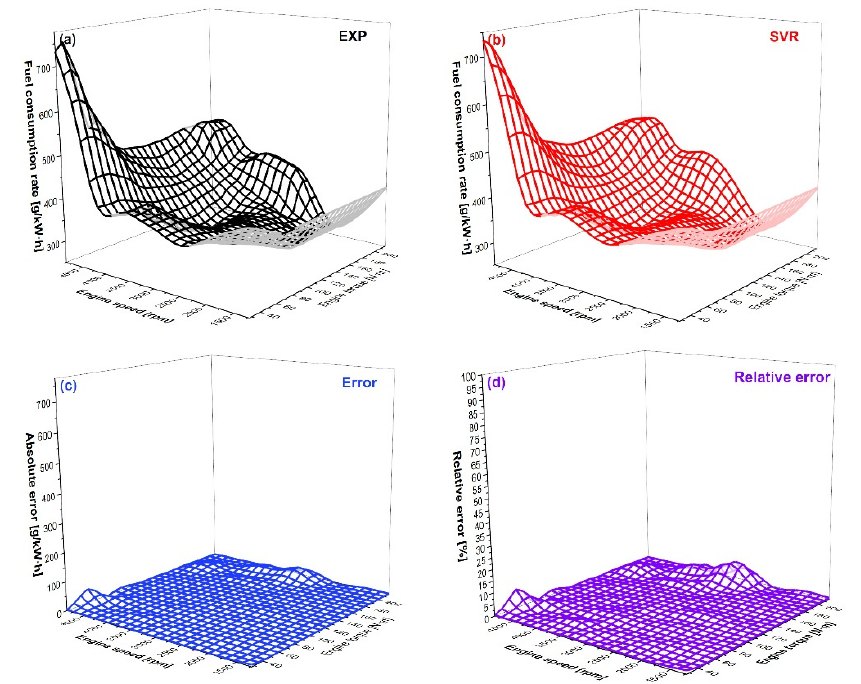
Figure 11. Comparison of SVR-predicted and experimental fuel-consumption-rate-established en- gine map. ( a ) The experimental data; ( b ) The SVR-predicted data; ( c ) The absolute error; ( d ) The relative error.